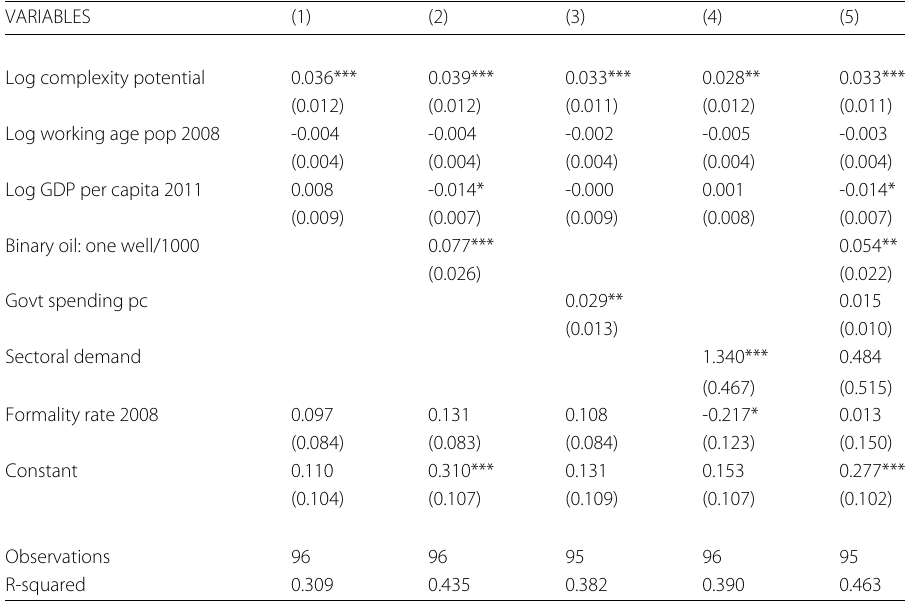
Table 1 This set of regressions explores the determinants of the change of the formal occupation rate between 2008-2013 for a set of 96 single-municipality cities